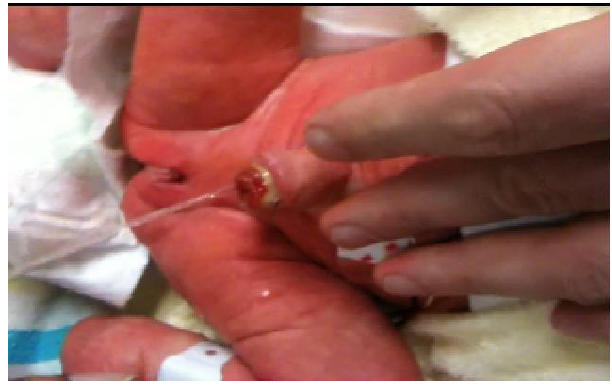
Figure 2. Urine jetting out of the umbilicus giving the impression of a